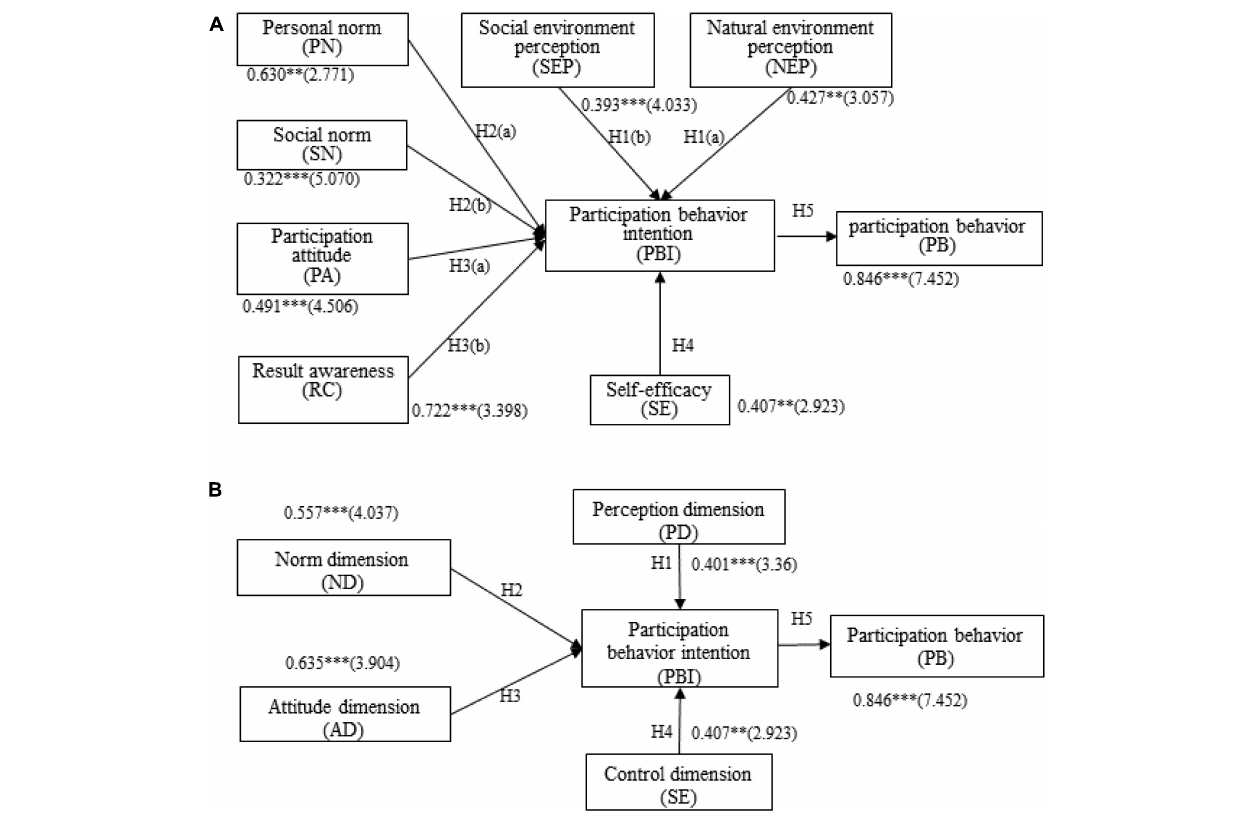
FIGURE 2 | Villagers participate in the test results of rural micro-landscape construction behavior model (A,B) . ∗ indicates a significant level P < 0.05, ∗∗ indicates a significant level P < 0.01, ∗∗∗ indicates a significant level P < 0.001; the number in parentheses is the corresponding t value.